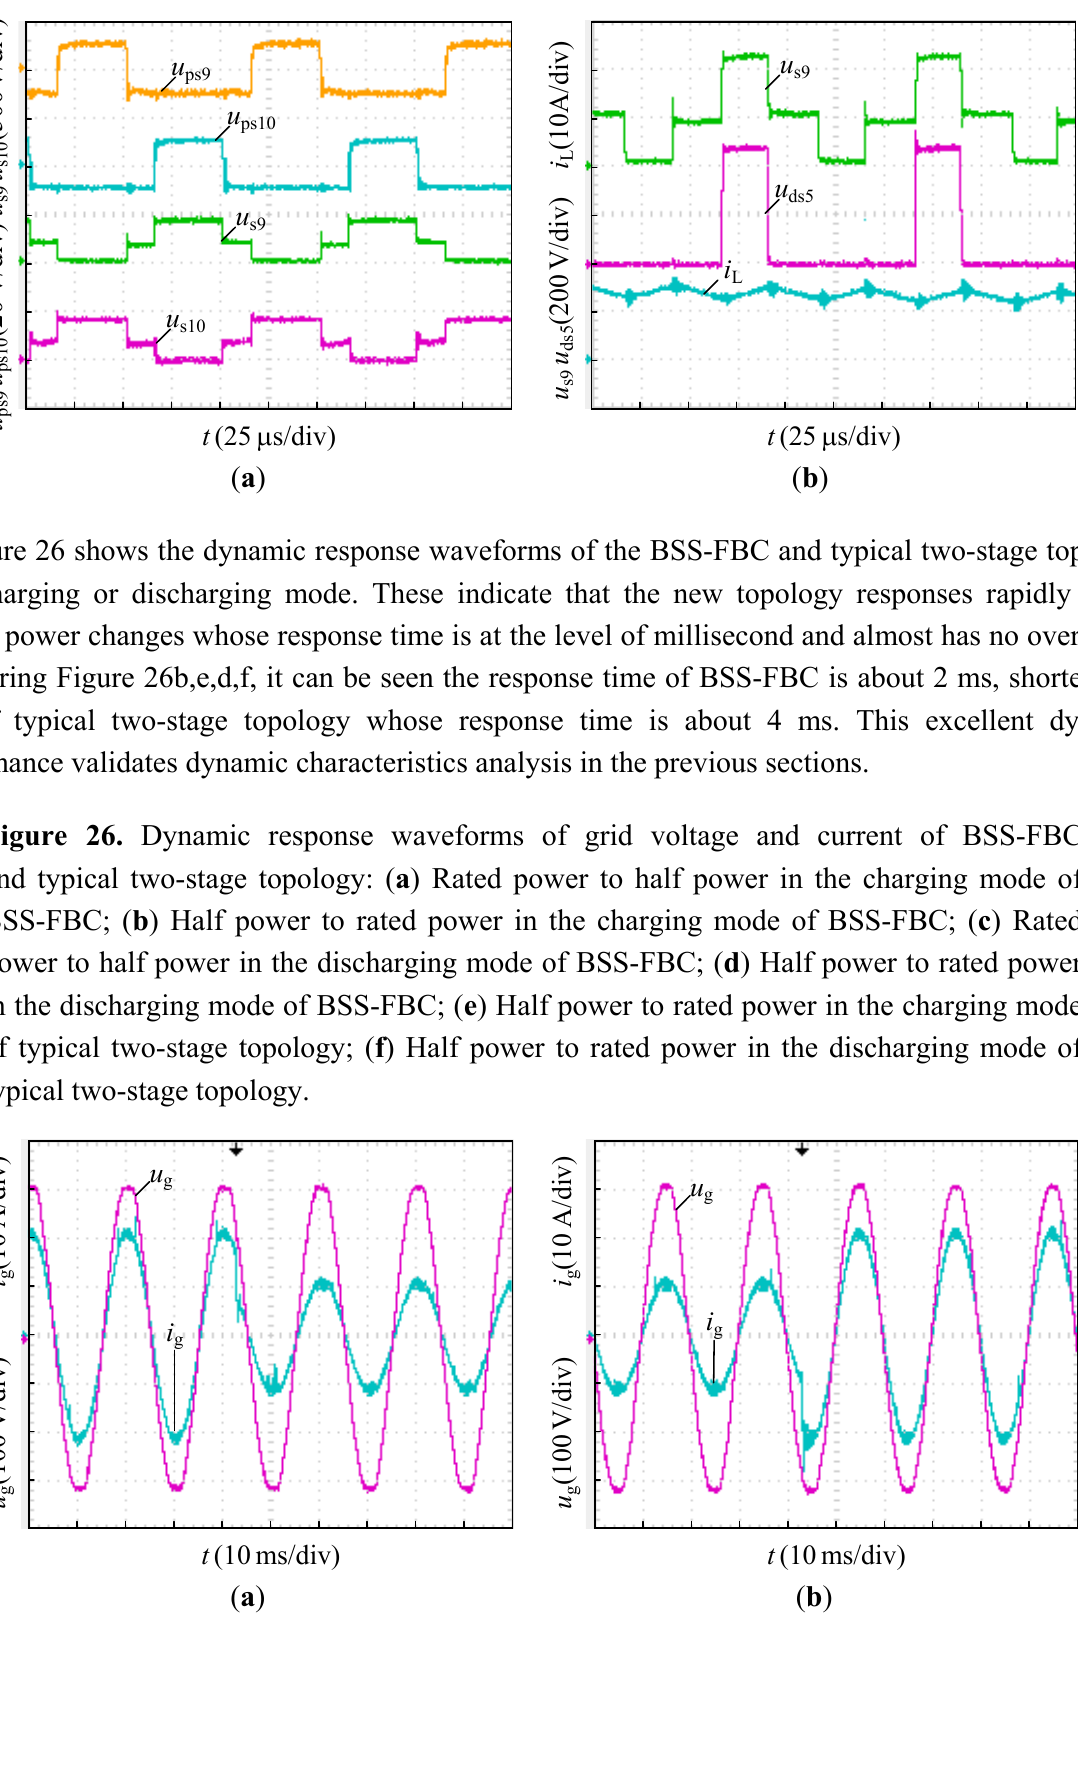
Figure 25. High-frequency operating waveforms of BSS-FBC in discharging mode: ( a ) Driving pulse and voltage stress of S freewheeling diode of S